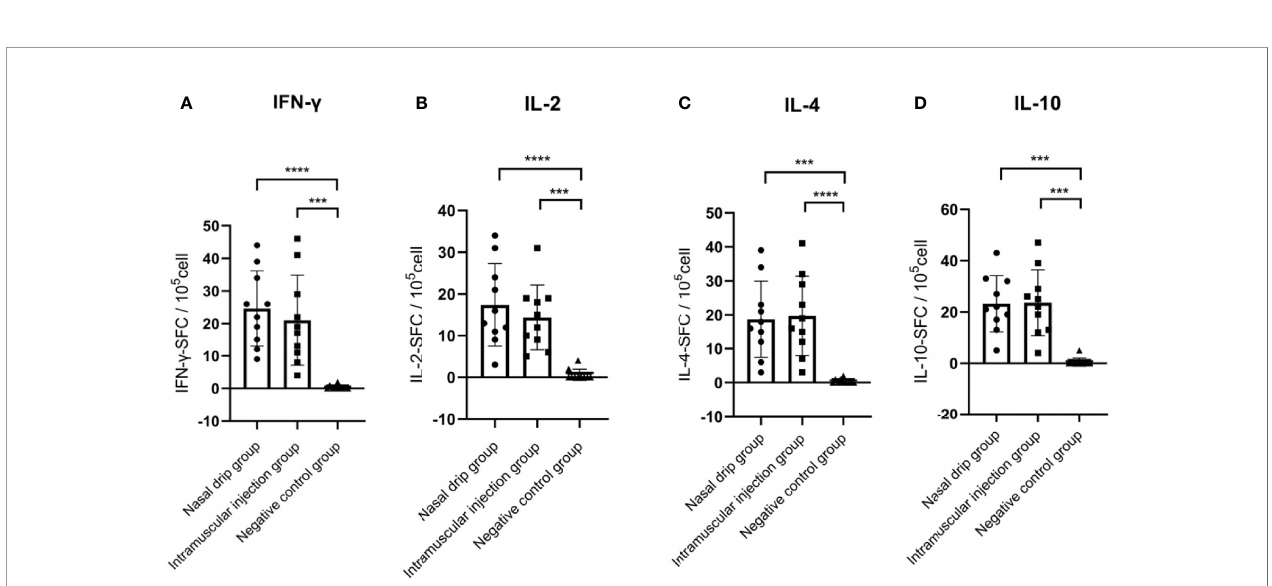
FIGURE 6 | Levels of splenocyte secreted cytokines in immunized BALB/c mice at 8 weeks after immunization detected by ELISPOT. (A) IFN- g , (B) IL-2, (C) IL-4, and (D) IL-10 levels. The numbers of cytokinepositive cells were shown as the mean counts of spot-forming unit (SFU) ± SD per 1×10 5 splenocytes. n = 10. Results were analyzed by the t test . ***p ＜ 0.0003; ****p ＜ 0.0001 .